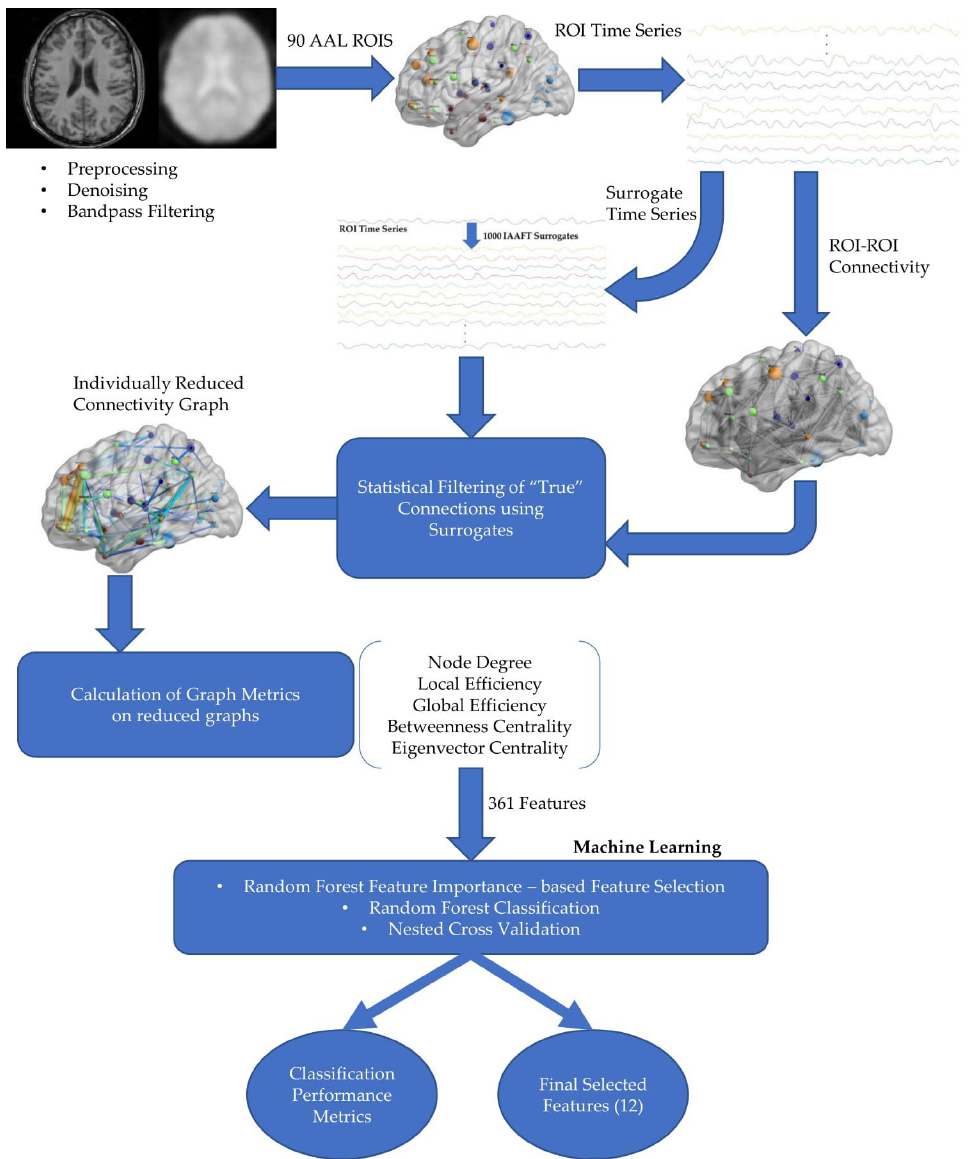
Figure 2. Diagram of proposed analysis pipeline.